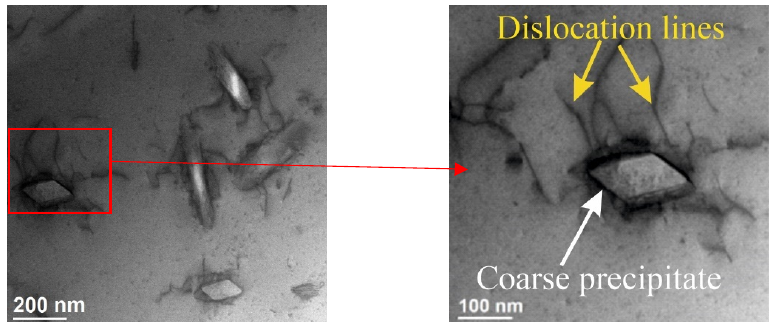
( b ), SAED from the [011] fcc Cu zone axis ( c ).